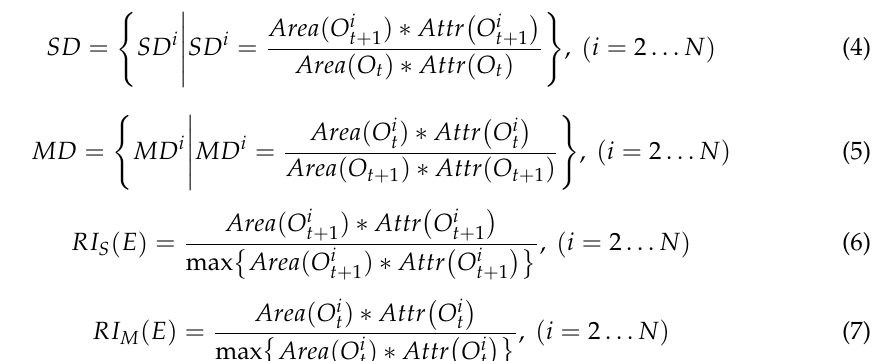
Figure 4. An iterative workflow to identify evolution relationships.